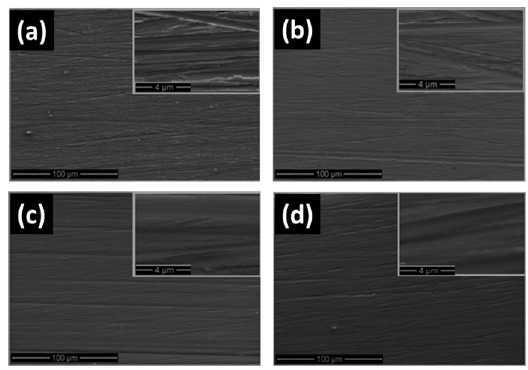
, (b) TiO -T, (c) TiO 2 2